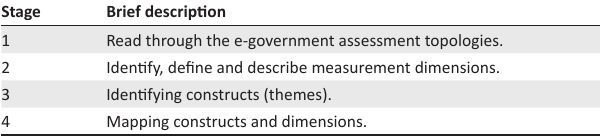
TABLE 1: Constant-comparative method used together with the thematic approach.